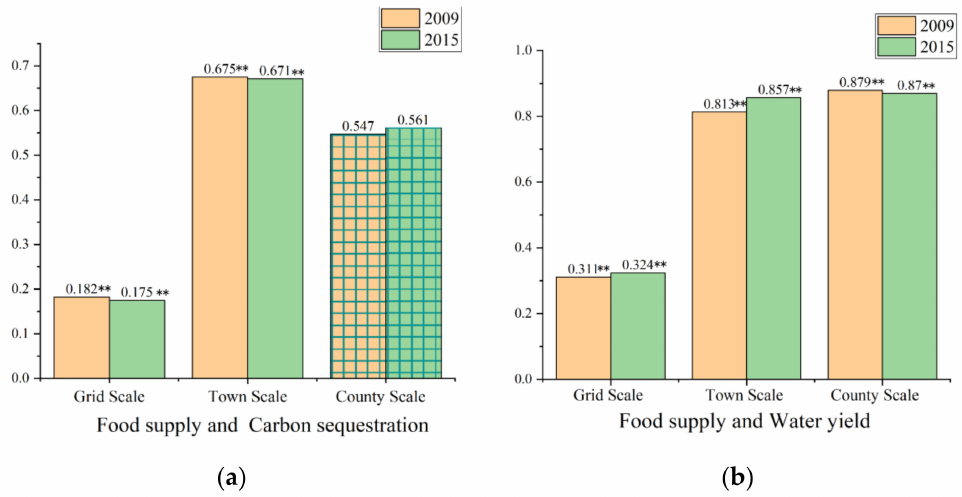
Figure 6. ( a ) Trade-offs/synergies of Food supply and Carbon sequestration at different scales; ( b ) Trade-offs/synergies of Food supply and Water yield at different scales; Trade-offs/synergies of Water yield and Carbon sequestration at different scales. ** Correlation is significant at the 0.01 level